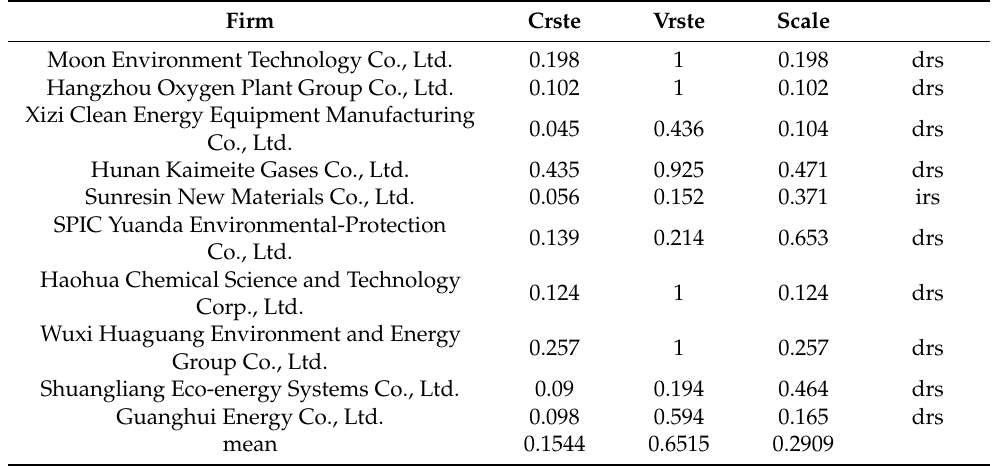
Table 6. 2021 Enterprise